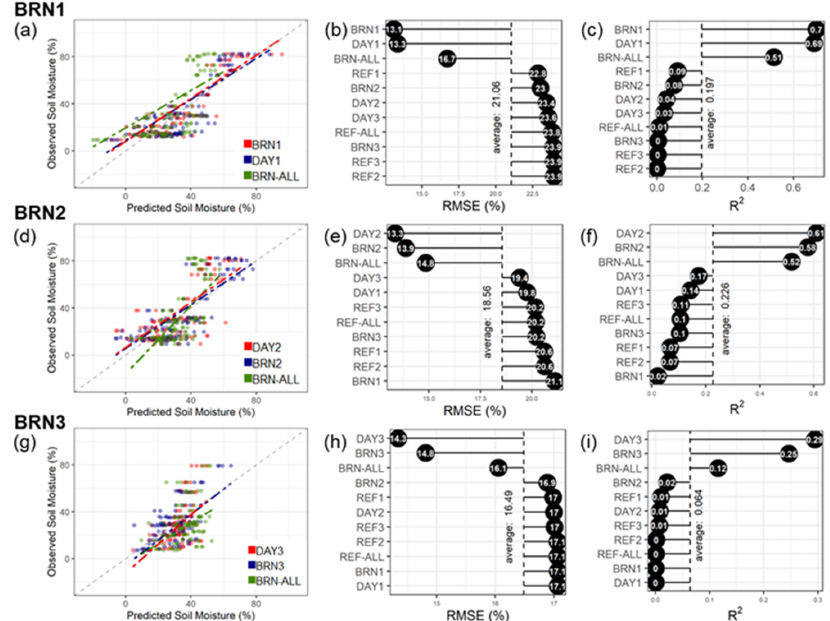
Figure 7. Summary plots of model validation using site-specific and independent datasets. The left panels display the scatterplot of the three best performance models for ( a ) BRN1 dataset, ( d ) BRN2 dataset, and ( g ) BRN3 dataset. The center panels present the ranking of models’ root-mean-square error (RMSE) for ( b ) BRN1 dataset, ( e ) BRN2 dataset, and ( h ) BRN3 dataset. The right panels present the ranking of models’ coefficient of determination (R 2 ) for ( c ) BRN1 dataset, ( f ) BRN2 dataset, and ( i ) BRN3 dataset.